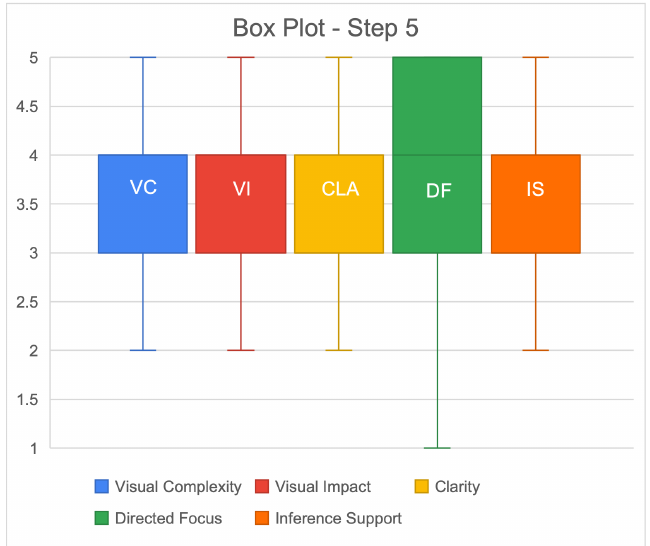
Figure 9. Boxplot chart for the results associated with the visual characteristics of Step 5 instructions— repeat the opposite procedure to install the new